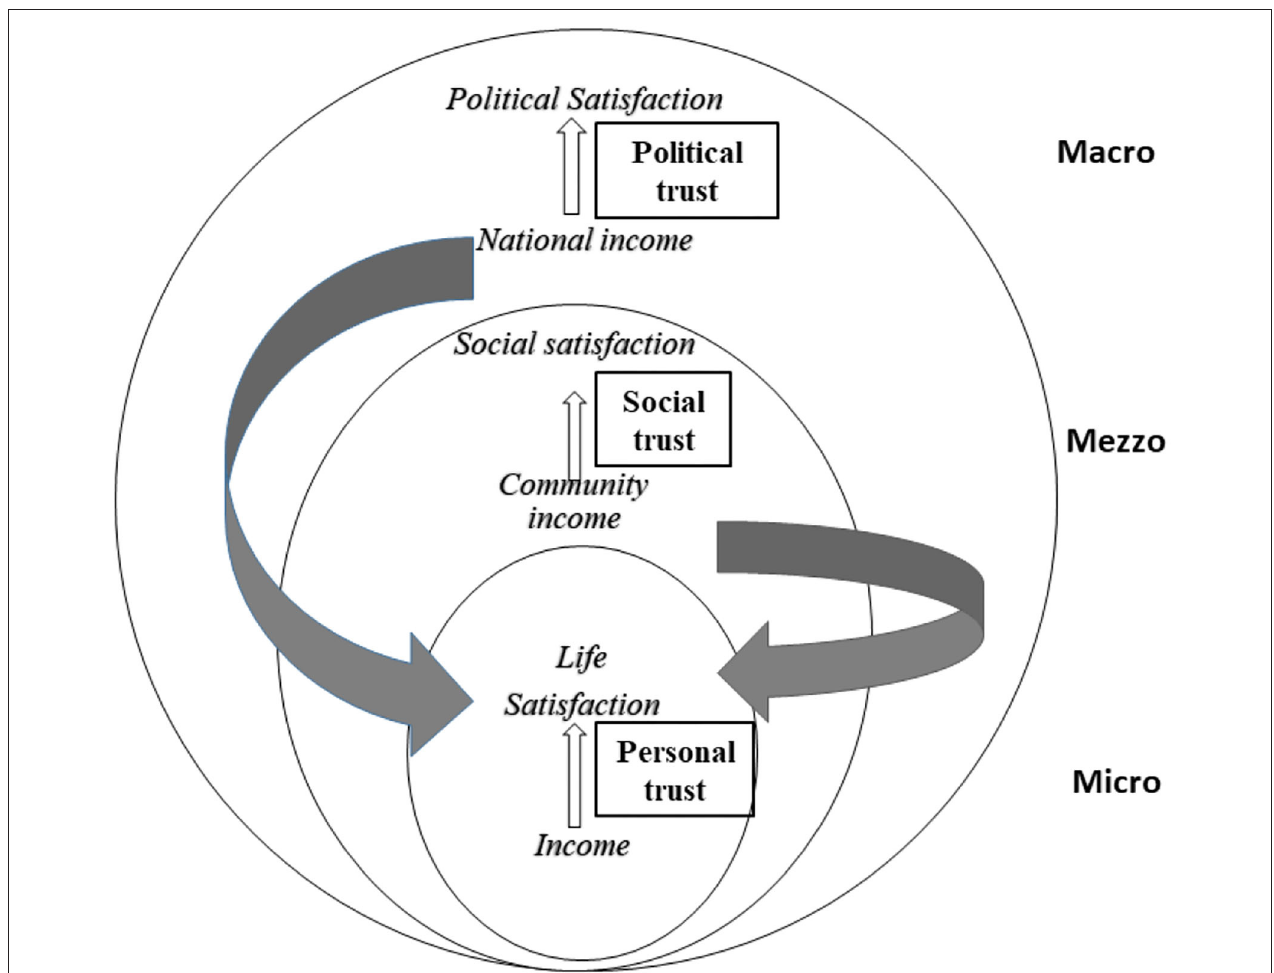
FIGURE 1 | A schematic presentation of the socio-structural model, indicating the three layers. Micro level = Individual. Mezzo level = Community. Macro level = Country. Indicators of income: Micro level = Personal income. Mezzo level = Community income. Macro level = National income. Indicators of satisfaction: Micro level: Personal life satisfaction (PLS). Mezzo level = Social satisfaction. Macro level = Political